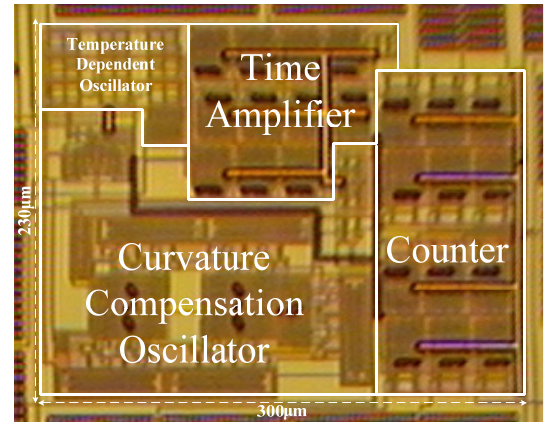
Figure 10. Microphotograph of the proposed sensor.